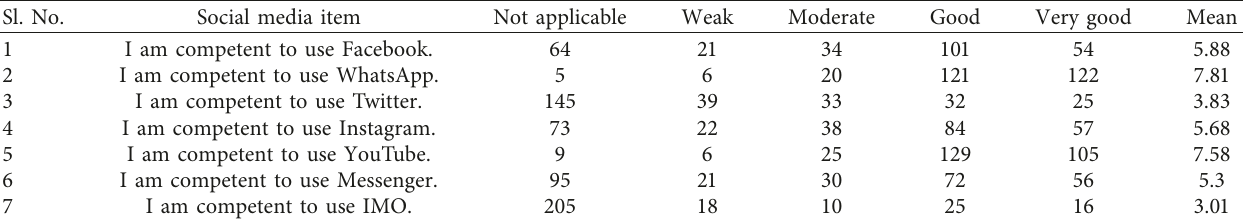
Table 5: Allocation, frequency, and mean on the respondents’ competency to use social